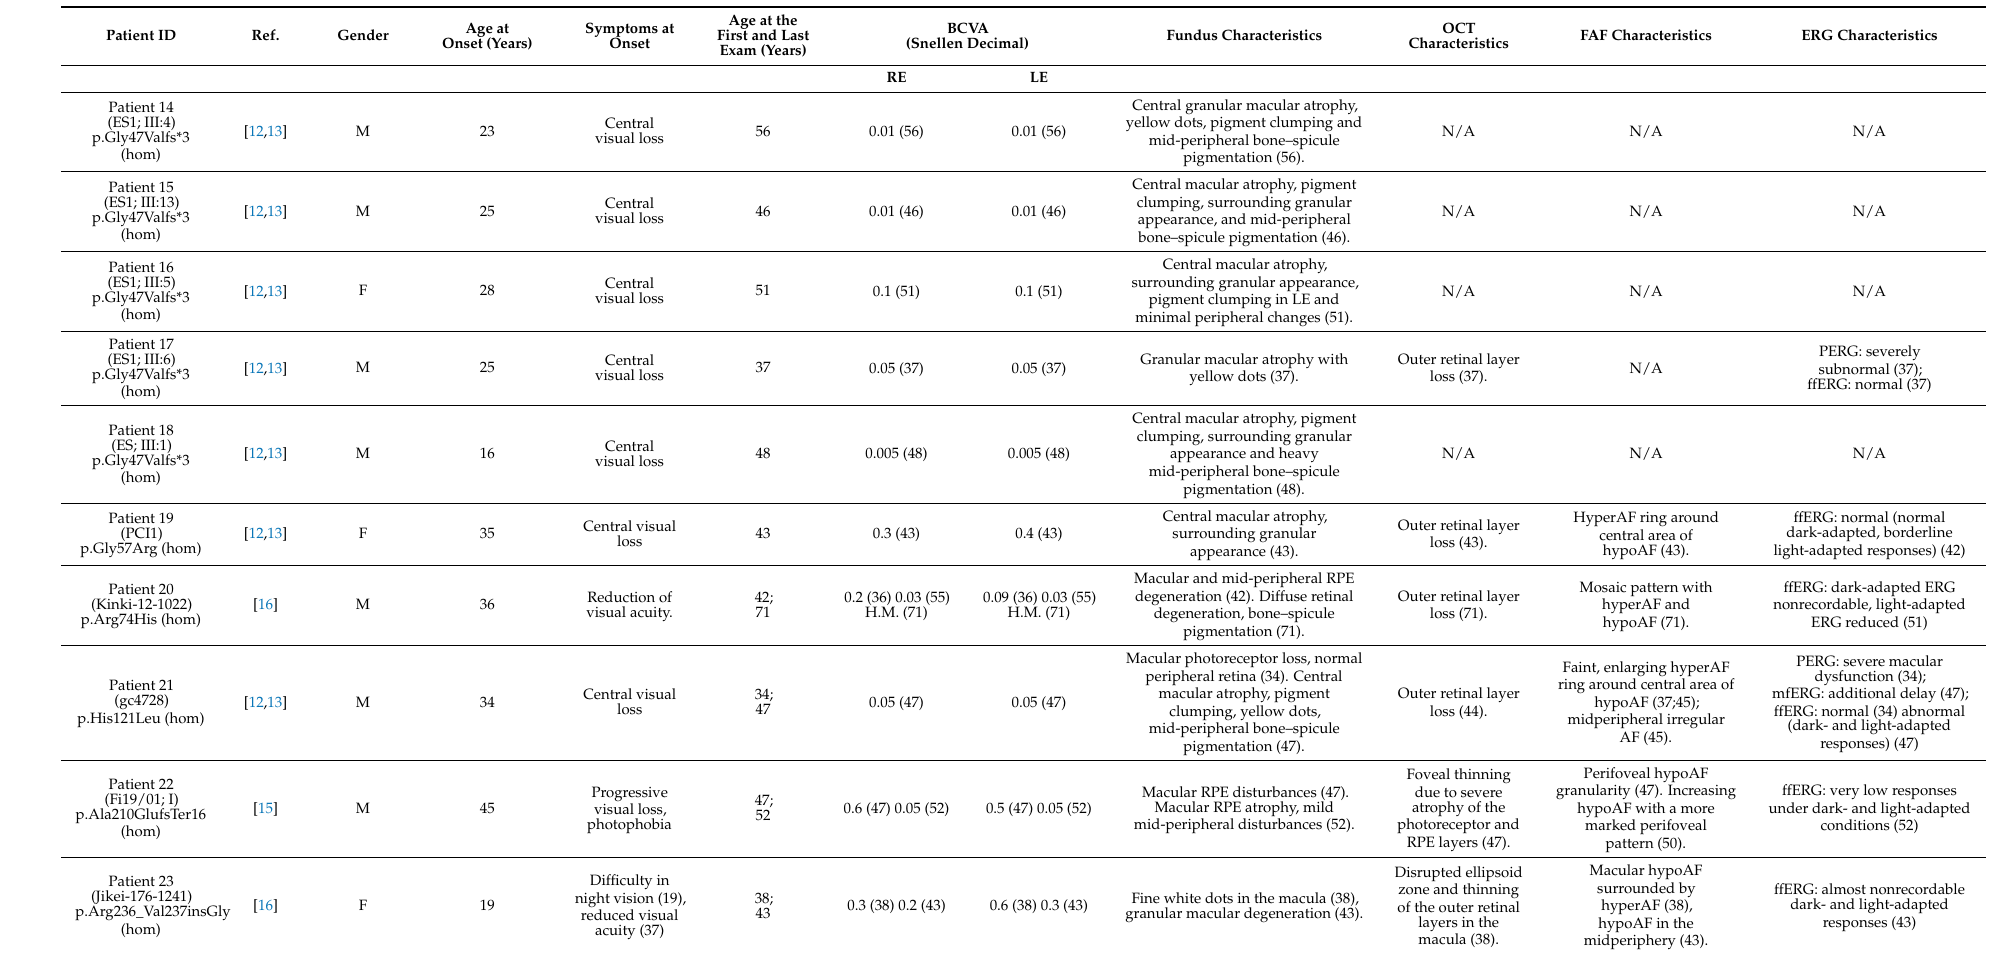
ffERG:normal(normal dark-adapted,borderline light-adaptedresponses)(42) ffERG:dark-adaptedERG nonrecordable,light-adapted ERGreduced(51) PERG:severemacular dysfunction(34); mfERG:additionaldelay(47); ffERG:normal(34)abnormal (dark-andlight-adapted responses)(47) ffERG:verylowresponses underdark-andlight-adapted conditions(52) ffERG:almostnonrecordable dark-andlight-adapted